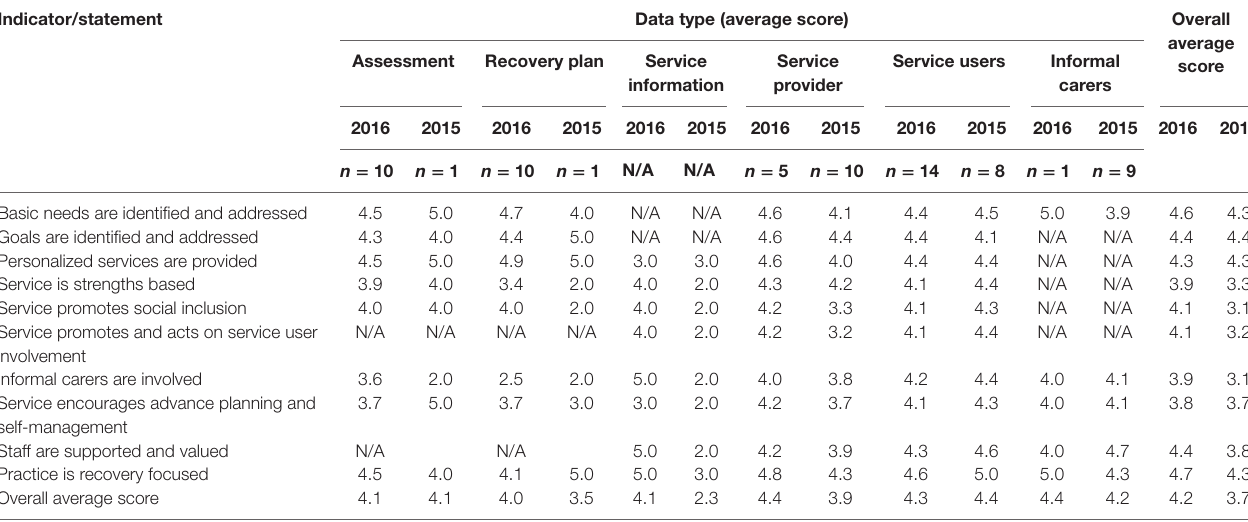
taBlE 2 | The Scottish Recovery Indicator 2 (SRI 2) data 2015 versus 2016.